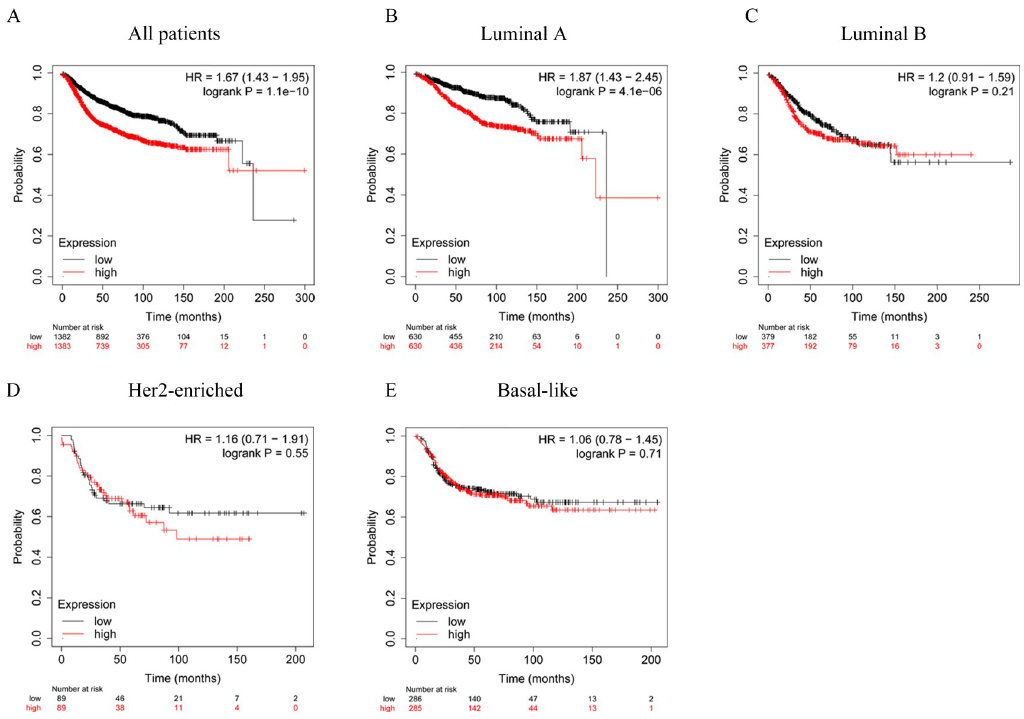
Fig 8. The effects of RRM2 expression on the DMFS of breast cancer patients. (A) All breast cancer patients, (B) Luminal A, (C) Luminal B, (D) Her-2 enriched, and (E) Basal-like.